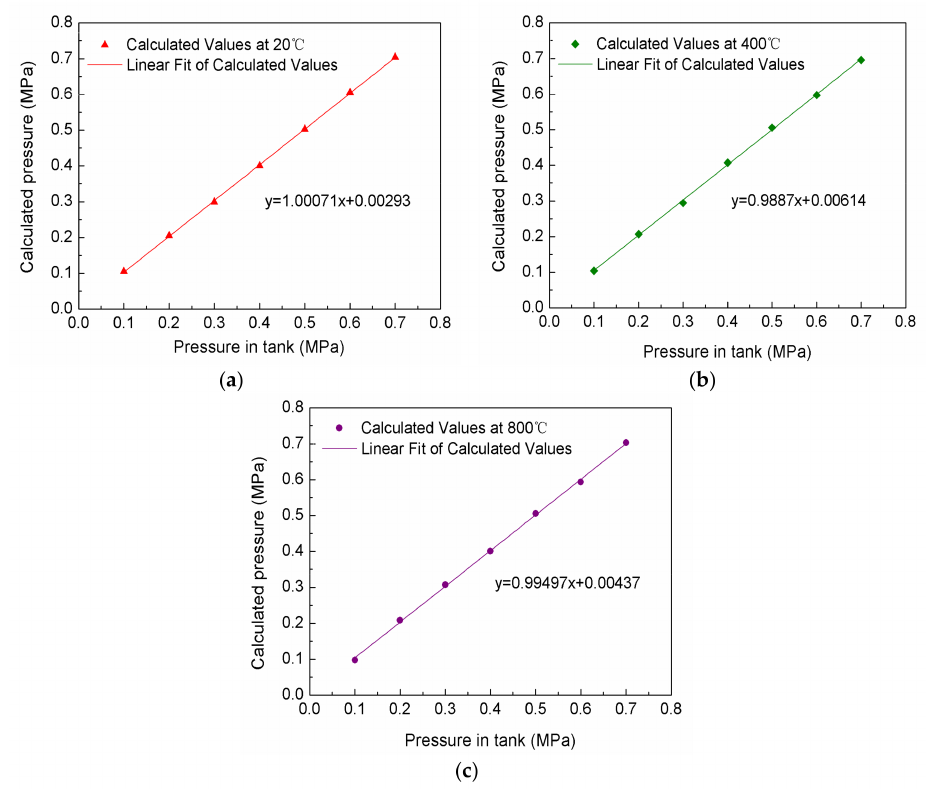
Figure 10. Temperature decoupling results: ( a ) at 20 ◦ C; ( b ) at 400 ◦ C; ( c ) at 800 ◦